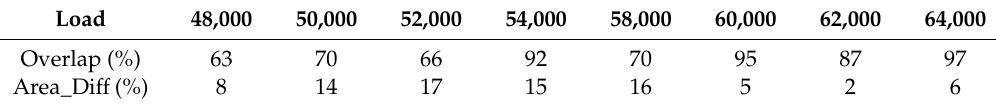
Table 7. Comparison of predicted crack shape from VAR model against ground